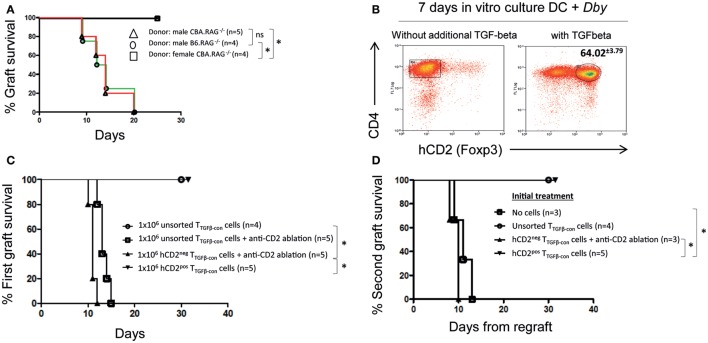
Antigen-specific TGF-β conditioned iTreg prevent graft rejection. (A) B6.RAG1−/− Marilyn.Foxp3hCD2 knock-in mice reject skin grafts from male B6.RAG1−/− and CBA.RAG1−/− mice. Female CBA.RAG1−/− lack male antigen and are accepted. Statistical analysis Log-Rank test; *p < 0.05, ns, not significant. (B) Generation of Dby-specific in vitro-induced Foxp3+ Treg (iTreg) from splenocytes derived from female B6.RAG1−/− Marilyn.Foxp3hCD2 mice in the presence or absence of additional TGF-β (2 ng/ml), Dby peptide, and female B6 wild-type derived bone marrow dendritic cells. Data representative of at least three experiments. (C) 1 × 106 unsorted and sorted TGF-β conditioned cells (iTreg) were adoptively transferred to lymphopenic B6.RAG1−/− mice with or without hCD2 ablation treatment. Mice received skin grafts from male CBA.RAG1−/− mice. Statistical analysis Log-Rank test; *p < 0.01. (D) Mice received an initial male CBA RAG1−/− skin graft and treatment as indicated. Thirty days following the first skin graft, 105 Marilyn CD4 T cells were injected i.v. and a fresh male CBA RAG−/− skin graft was transplanted on the contralateral flank of recipients. Statistical analysis Log-Rank test; *p < 0.01. All data representative of three separate experiments.